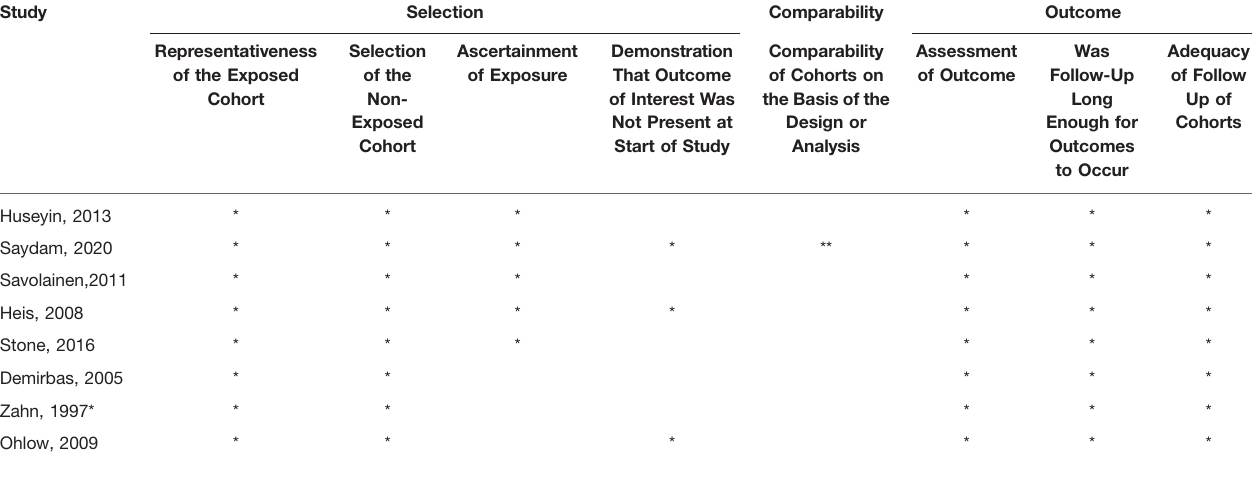
TABLE 3 | Quality appraisal checklist for the included